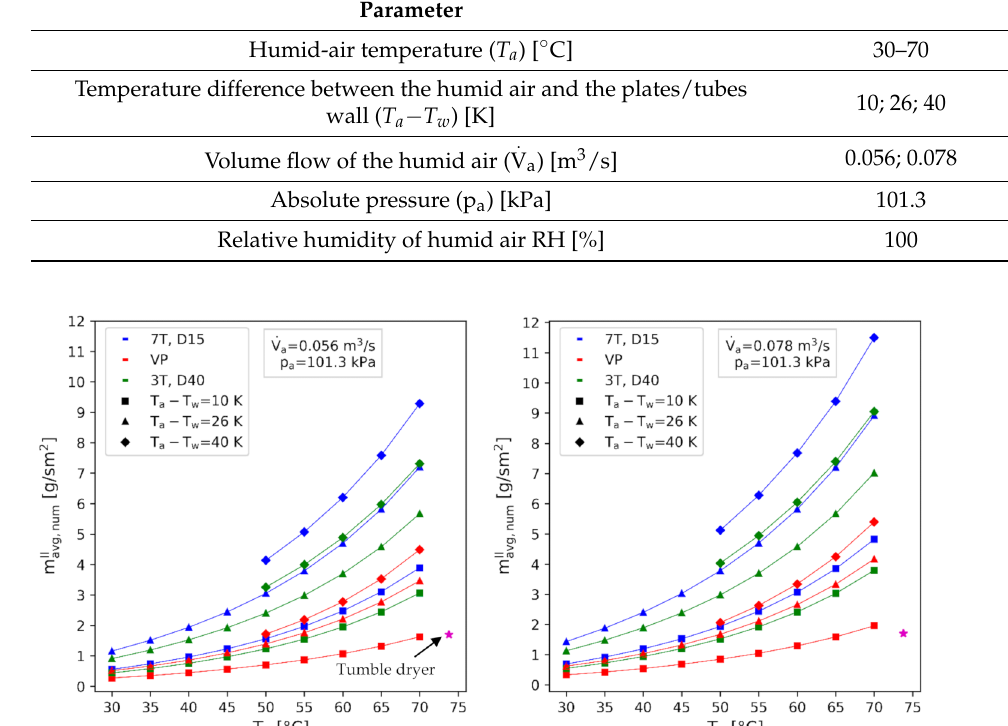
Table A6. Range of parameters used for parametric analysis.